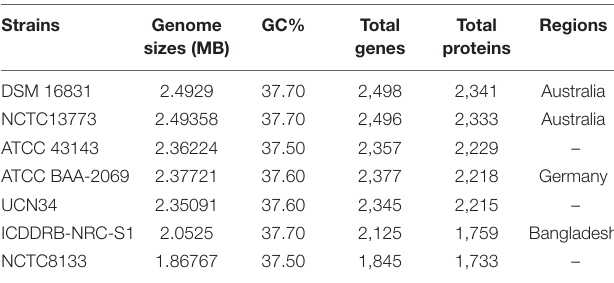
TABLE 1 | Strains of Streptococcus gallolyticus with information on genome statistics and regions of isolation. Strains Genome sizes (MB)